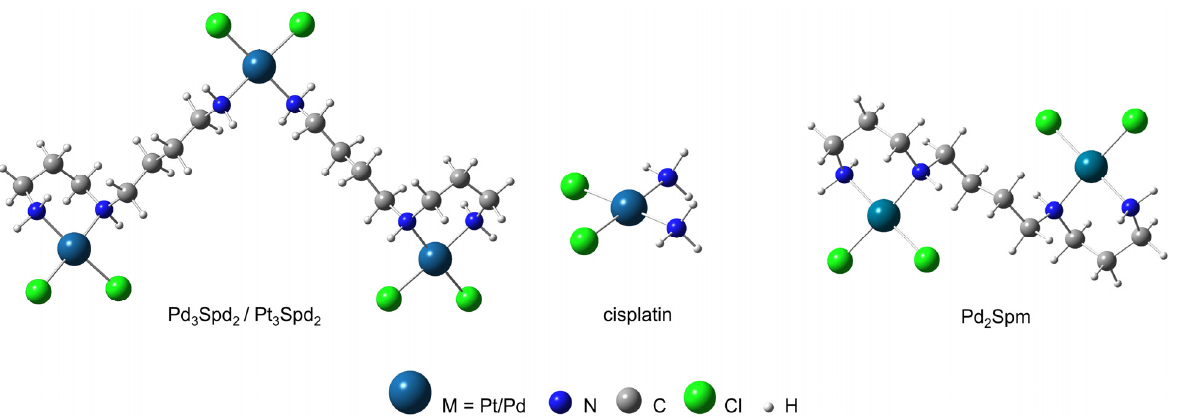
Figure 1. Structure of Pt(II)- and Pd(II)-based agents: Pd(II) or Pt(II) trinuclear chelates with sper- midine, Pd 3 Spd 2 or Pt 3 Spd 2 ; conventional mononuclear Pt(II) drug—cisplatin and Pd(II) dinuclear chelates with spermine Pd 2 Spm.